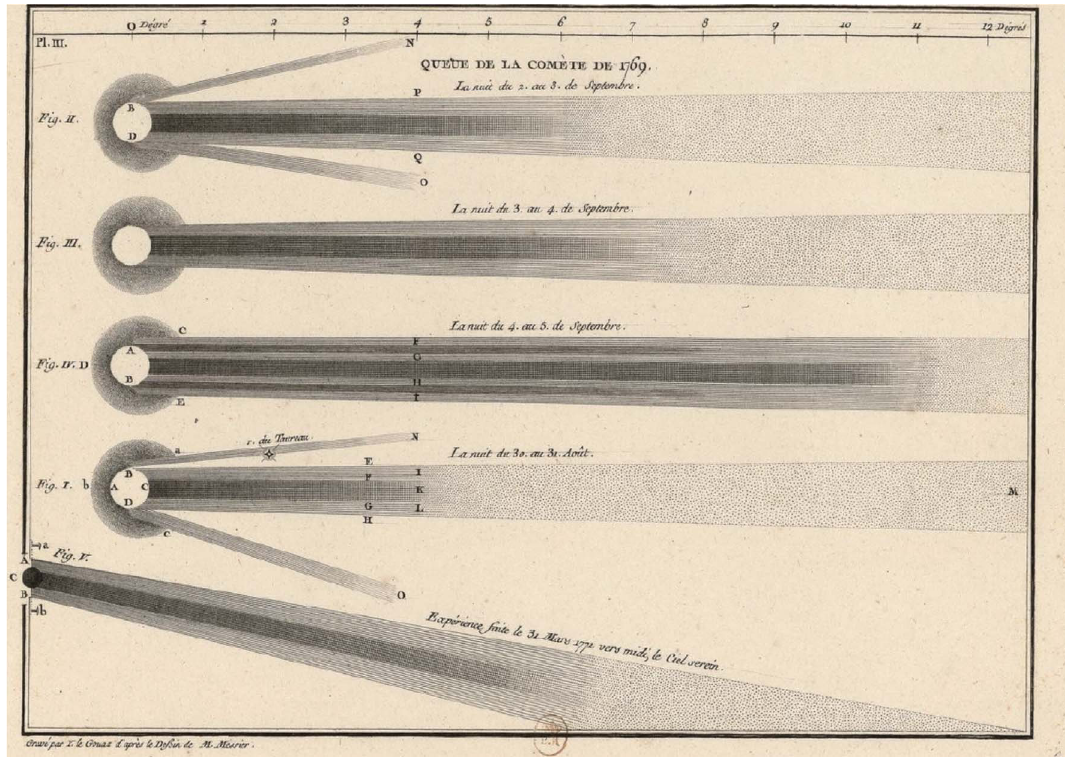
Fig. 2. Cometary diagrams by Messier and Le Gouaz (1775) for C/1769 P1, with courtesy of Bibliothèque nationale de France. Its branched tail was interpreted as a plasma tail in Zolotova et al. (2018), using Messier ’ s different